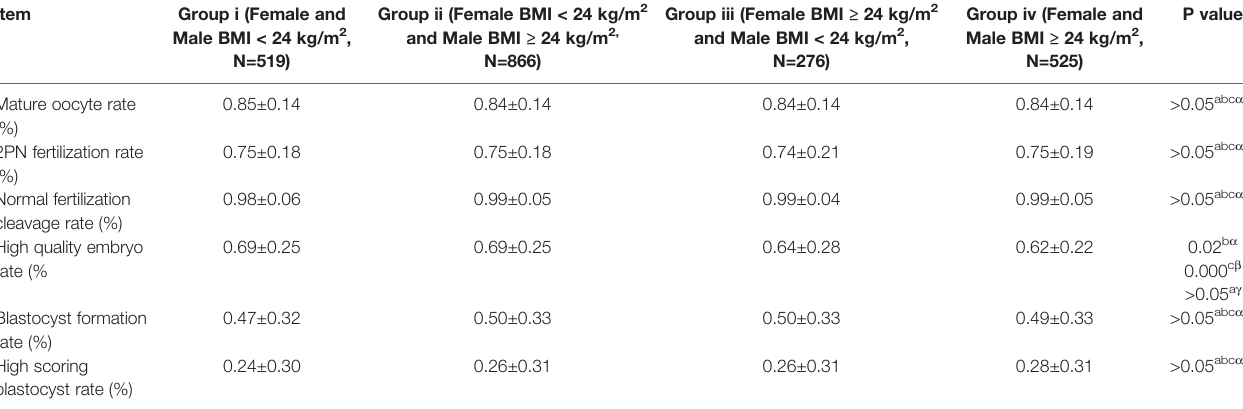
TABLE 2B | Effect of female and Male BMI on oocytes maturation, fertilization, embryo development, and embryo quality in ICSI cycles.